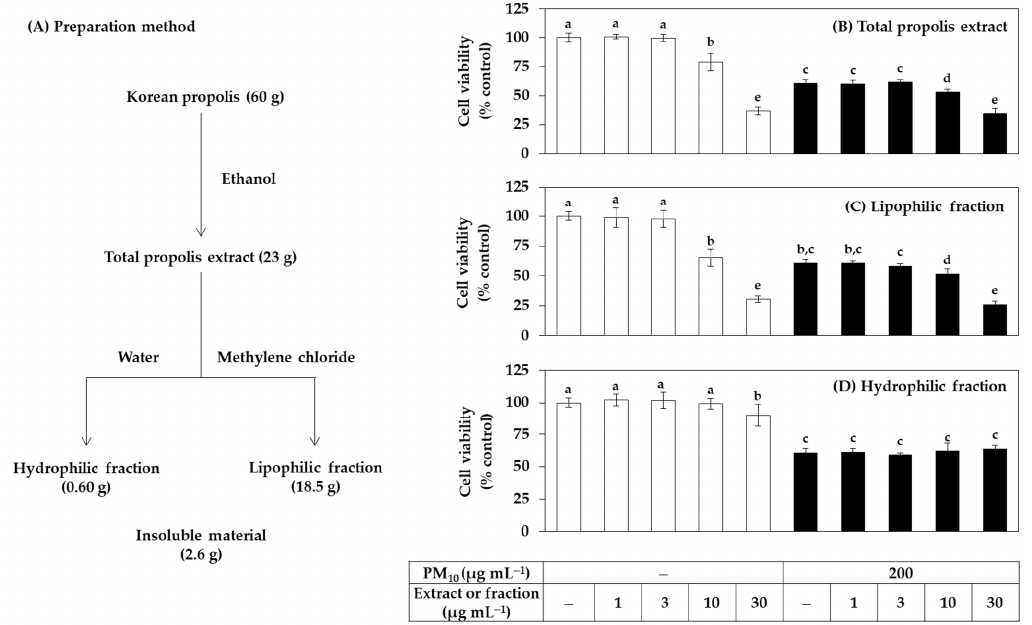
Figure 1. Effects of total propolis extract and its solvent fractions on the viability of human HaCaT keratinocytes exposed to PM 10 . In ( A ), the total ethanolic extract of Korean propolis was divided into a hydrophilic and a lipophilic fraction by solvent partition between water and methylene chlo- ride. Cells were treated with the total extract ( B ), a lipophilic fraction ( C ), or a hydrophilic fraction ( D ) at the specified concentration alone or in combination with PM 10 (200 μg mL −1 ) for 48 h. Cell viability was determined by the 3-(4,5-dimethylthiazol-2-yl)-2,5-diphenyl tetrazolium bromide (MTT) assay. Data are presented as mean ± SD ( n = 5). ( D ) Duncan’s multiple range test was per- formed to compare all group means to each other. Groups that share the same letters (a–e) do not have significantly different means at the p < 0.05 level.